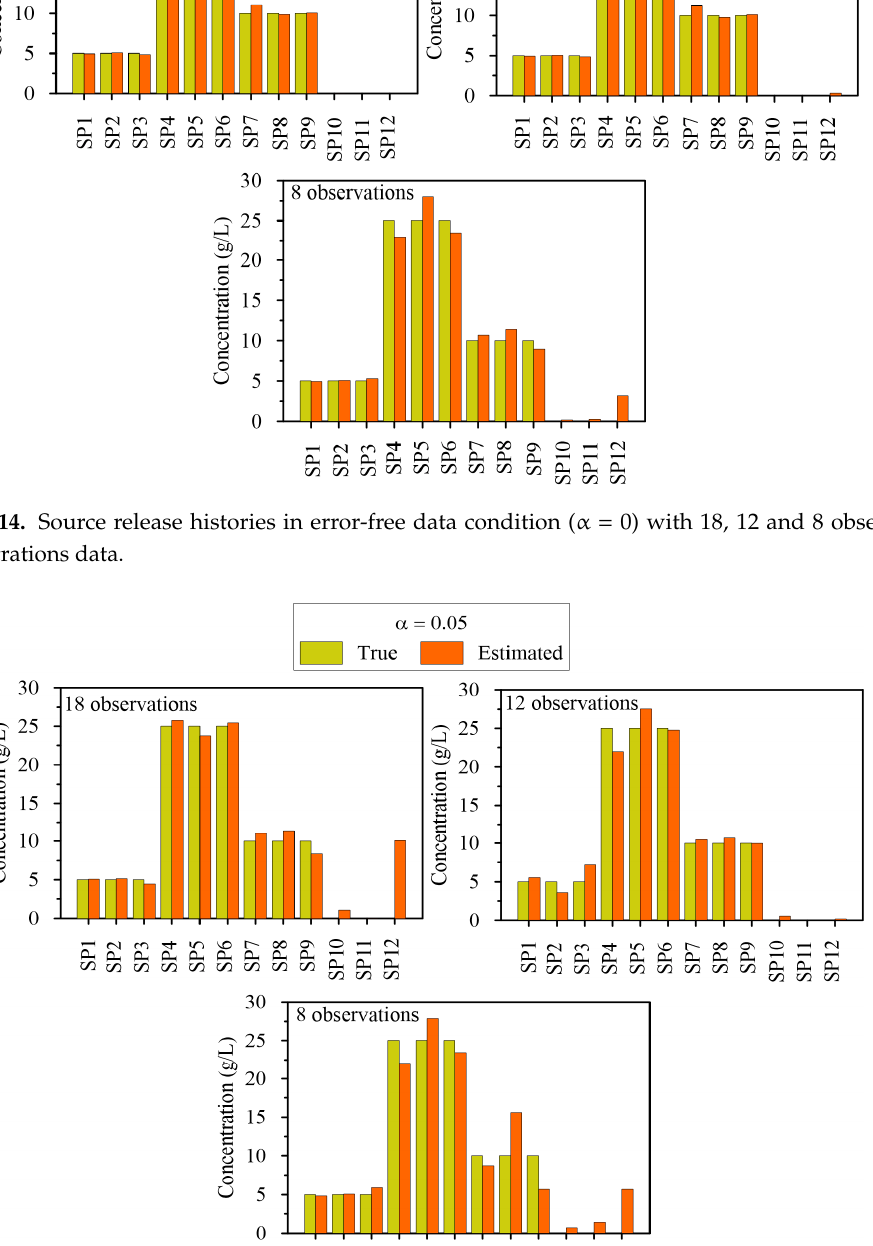
Figure 16. Source release histories in error-perturbed data condition ( α = 0.1) with 18, 12 and 8 observed concentrations data.